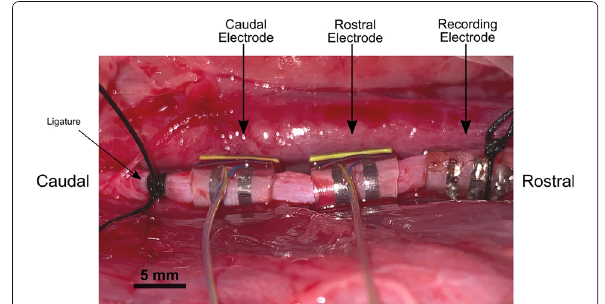
Fig. 1 Electrode placement on the isolated, left cervical vagus of a swine for the LFAC experiments. The CE, a bipolar cuff, was used for vagal stimulation. The LFAC conditioning waveform was presented at the RE. A tripolar recording electrode for ENG recordings was placed most rostral on the vagus nerve and secured with suture. A ligature was placed caudal to all three electrodes to eliminate cardiac effects